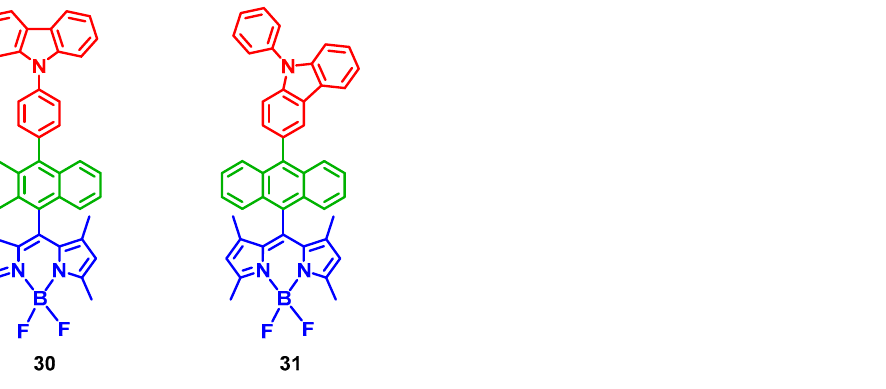
Figure 10. Donor-Donor-Acceptor triads showing SOCT-ISC in both low polar and high polar solvents. Blacha-Grzechnik et al. prepared a class of bora fl uorene − ligand dyads 32 − 34 , for